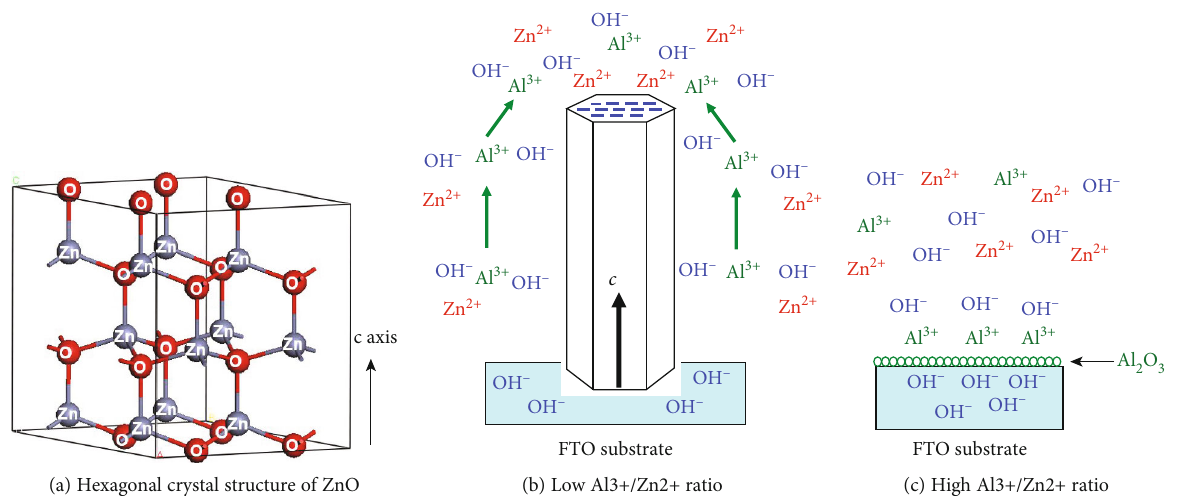
Figure 10: Schematic diagram of growth principle of ZnO nanorods on FTO substrates by electrodeposition method with di ff erent Al 3+ /Zn 2+